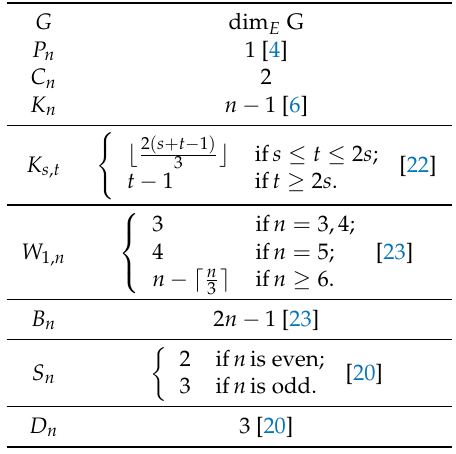
Table 1. Edge version of the metric dimension of